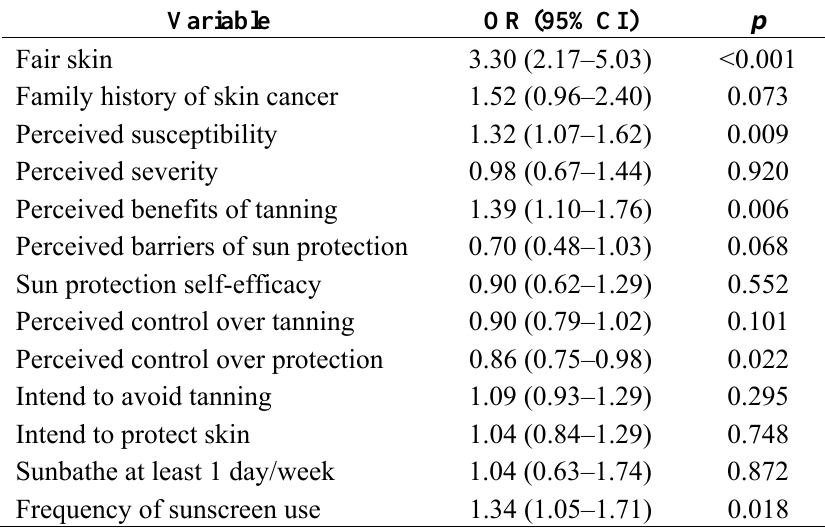
Table 2. Multivariable model showing associations between sunburn status and biological, attitudinal, and behavioral factors (n =